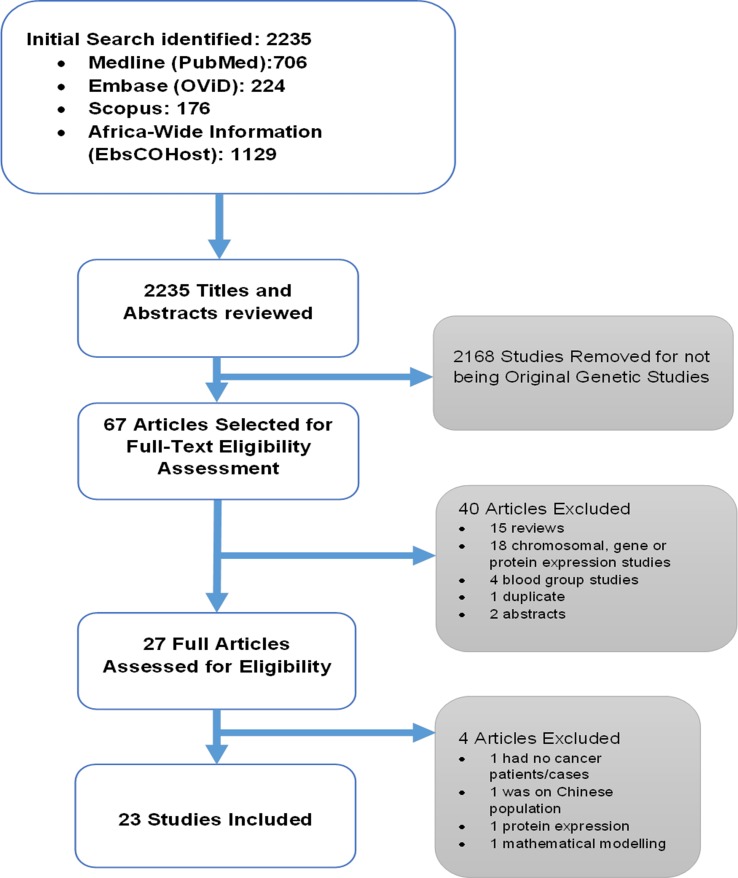
Outline of the systematic review.